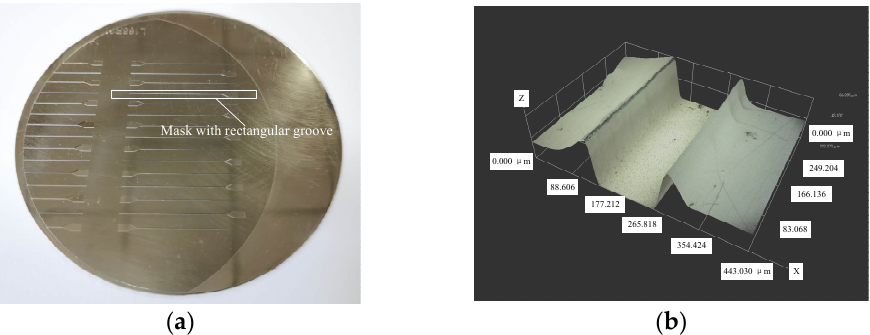
Figure 7. Results of preparing mask with rectangular grooves: (a) two-dimensional overall view; (b) local three-dimensional topography.